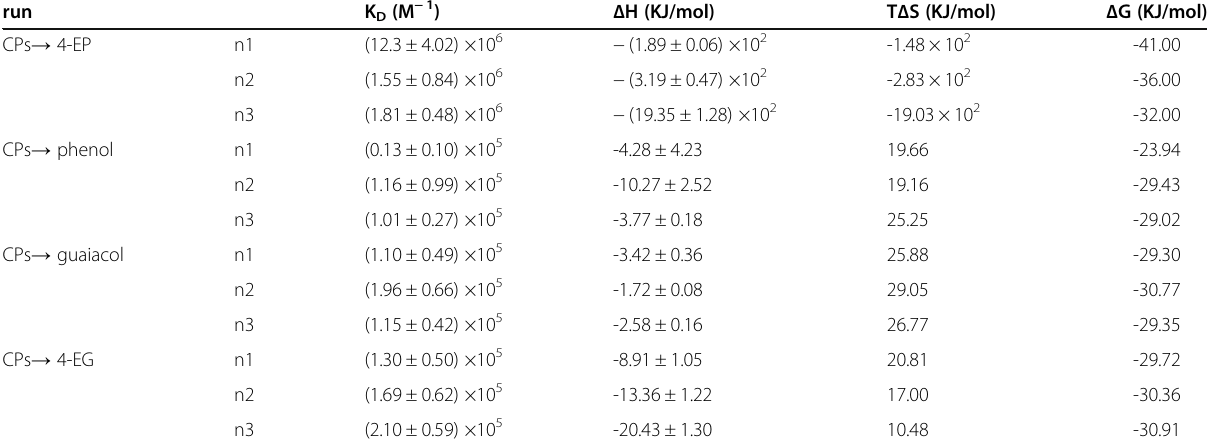
Table 1 Thermal parameters of collagen peptides reacted with phenolic compounds in 52 % ethanol-water solution run